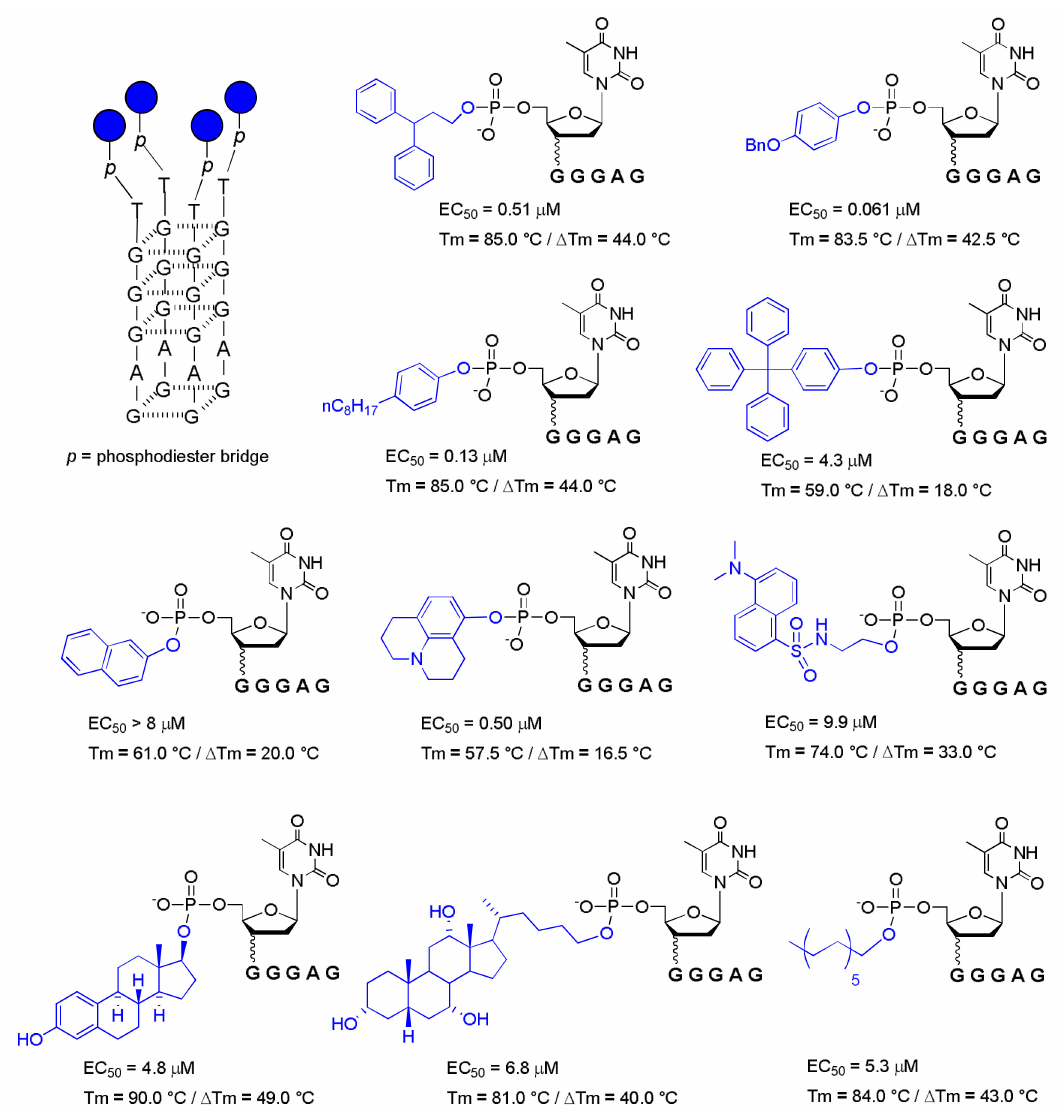
Figure 2. Anti-HIV activity (EC 50 ), thermal stability (T m ) and ∆ T m (the difference between the T m of modified sequence and that of the natural one) of some 5 (cid:48) -end modified d(TGGGAG) sequences